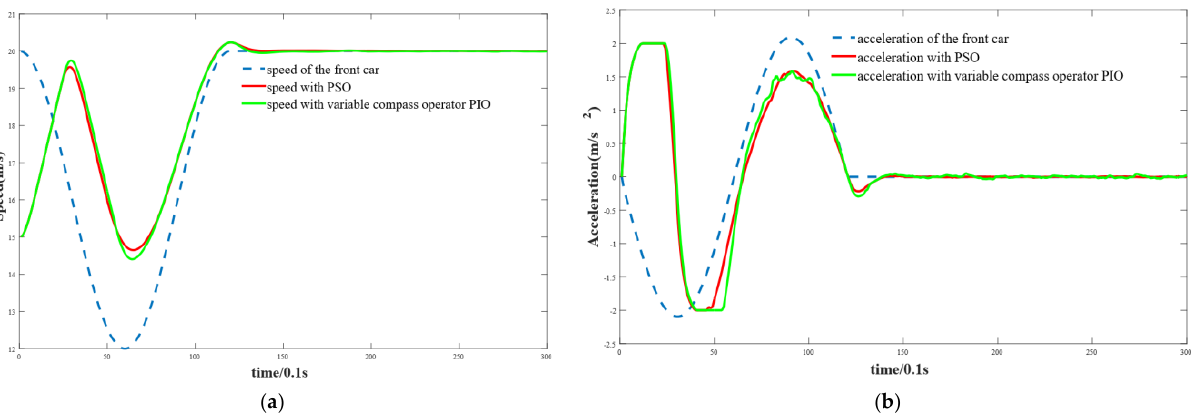
Figure 2. Comparison of PSO and variable compass operator PIO in terms of ( a ) speed and ( b ) acceleration.